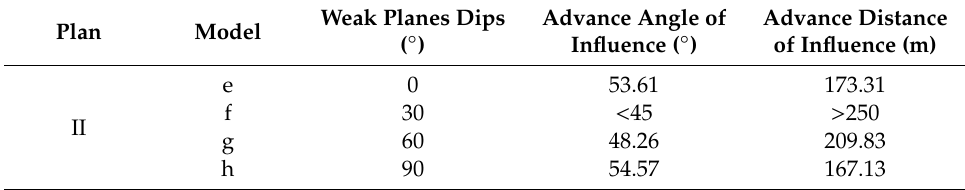
Table 3. Numerical simulation results of influence of weak planes heights on surface